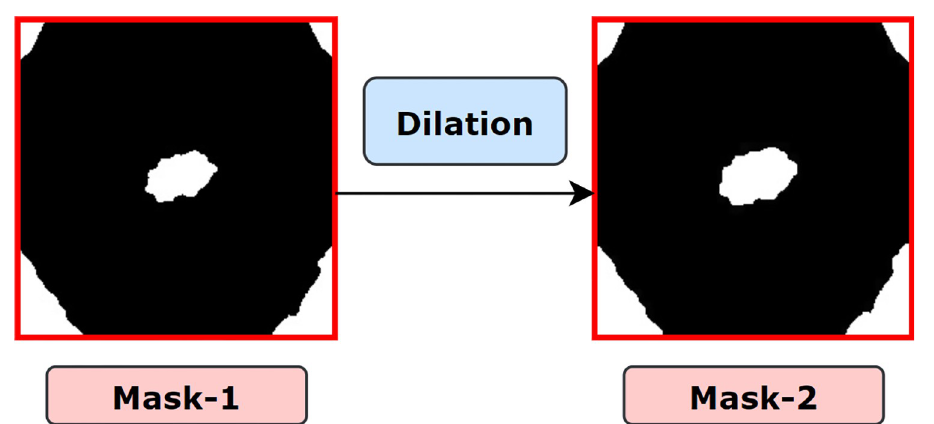
Fig 12. Resultant mask after applying morphological dilation.